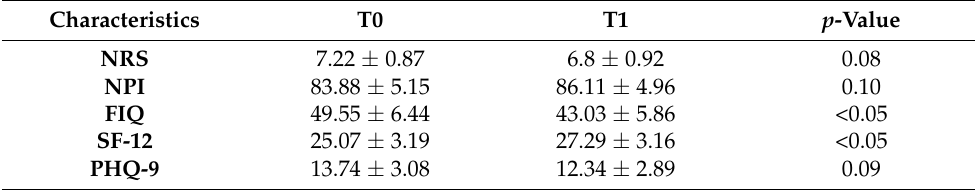
Table 3. Effects of functional rehabilitation alone in control group at